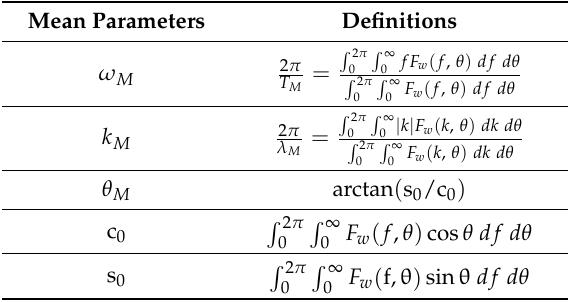
Table 2. Expression of the relevant mean spectra